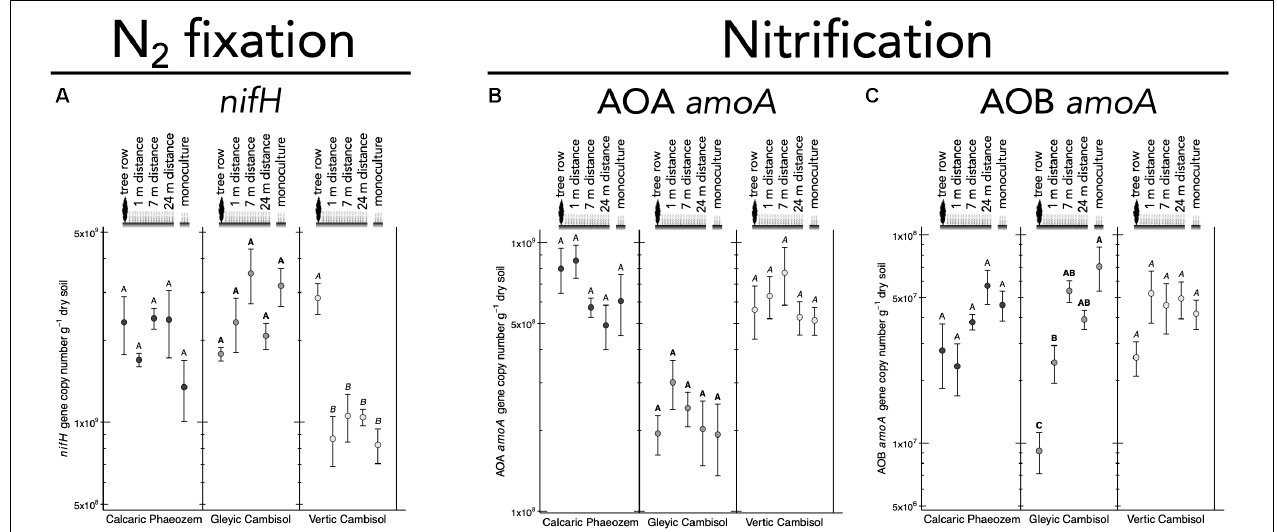
FIGURE 5 | Gene abundance of (A) nifH , (B) AOA amoA , and (C) AOB amoA in soil of three paired temperate agroforestry and monoculture cropland systems. Means (bars are standard errors; n = 4) with different uppercase letters indicate statistically significant differences among the sampling locations (the tree row, 1, 7, and 24 m within the crop row of the agroforestry and the monoculture croplands) within one soil type (one-way ANOVA with Tukey’s HSD test of log 10 -transformed data at p < 0.05). AOA = ammonia-oxidizing archaea, AOB = ammonia-oxidizing bacteria.